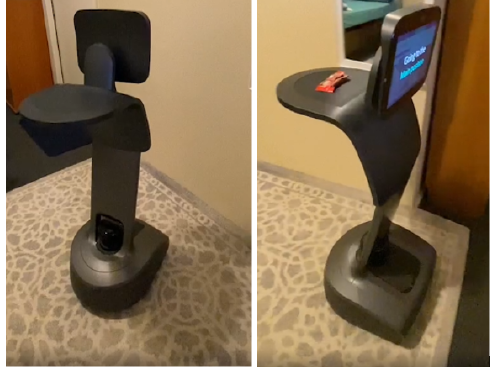
Figure 8. Robot completing delivering an item request.